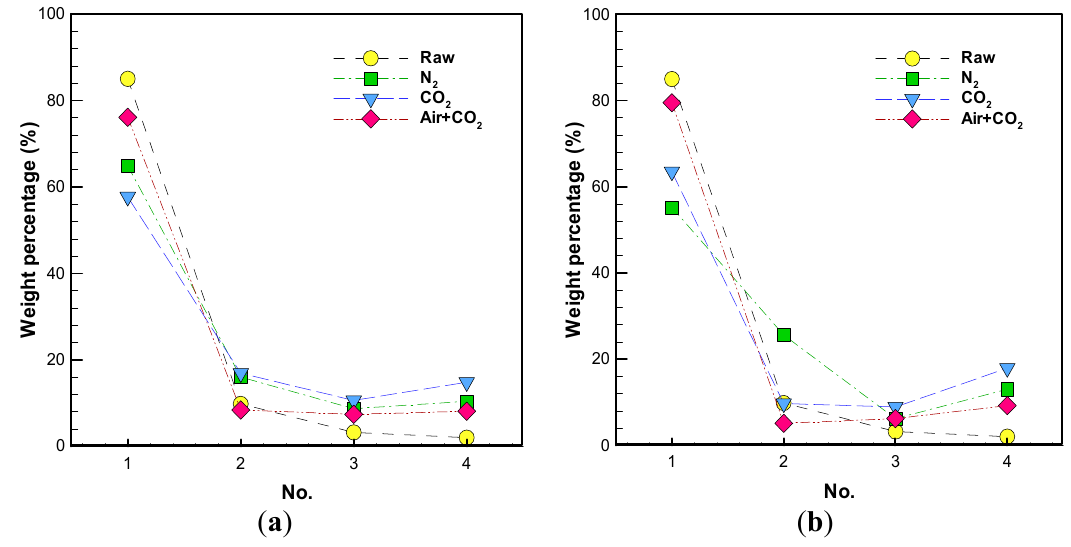
Figure 9. Particle size distributions of raw and torrefied corncob wastes at the torrefaction temperatures of ( a ) 250 °C and ( b ) 300 °C (No. 1: > 100 mesh; No. 2: 100–200 mesh; No. 3: 200–325 mesh; No. 4: < 325 mesh).